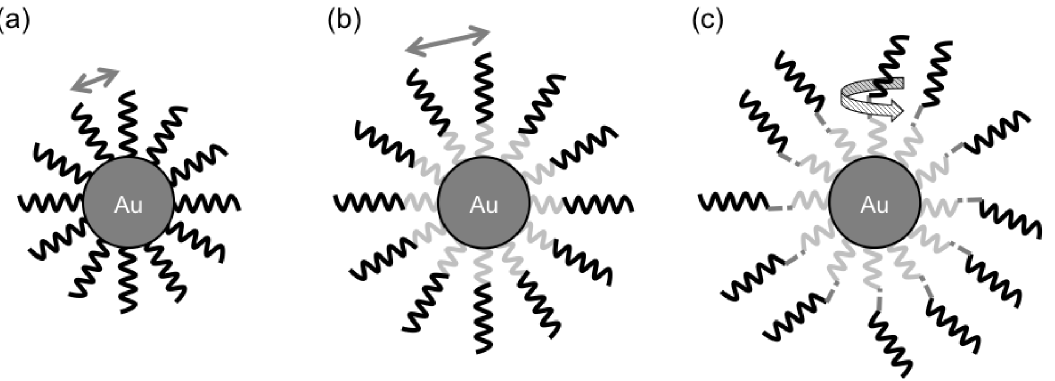
Figure 1. CpG AuNP conjugate design schematics. (a) Design 1, CpG-SH, directly has CpG (black lines) assembled on the AuNP surface. (b) Design 2, CpG-T11-SH, incorporates a poly-T nucleotide spacer (light gray lines) to increase the spacing between CpGs (straight arrows). (c) Design 3, CpG-TEG-T11-SH, adds a triethylene glycol (dark gray dotted line) between the CpG sequence and the nucleotide spacer to allow rotation of the CpG segment (curved arrow).